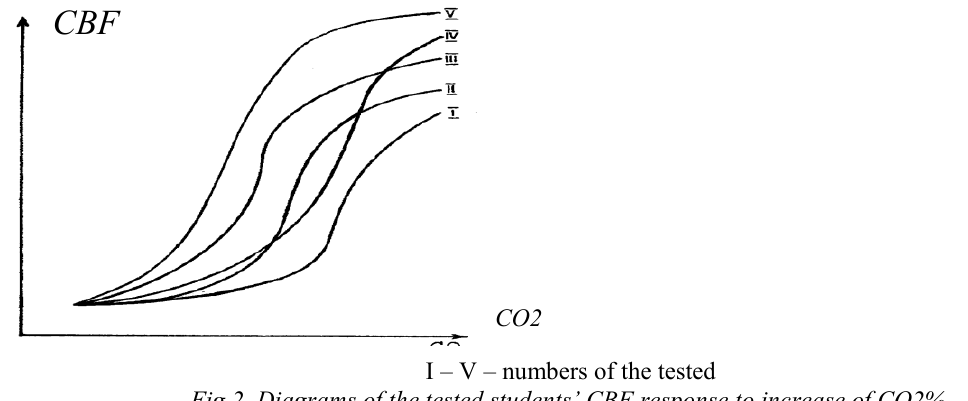
Fig.2. Diagrams of the tested students’ CBF response to increase of